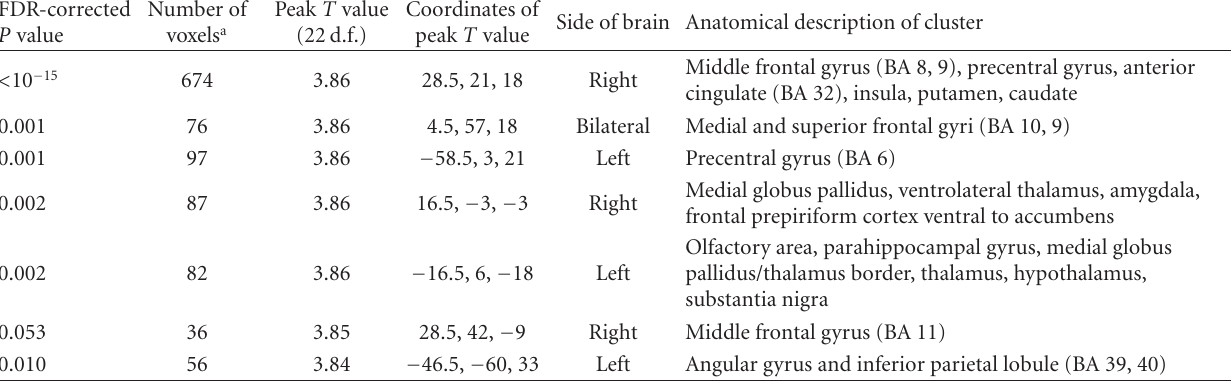
Table 3: CBF correlates with emotional